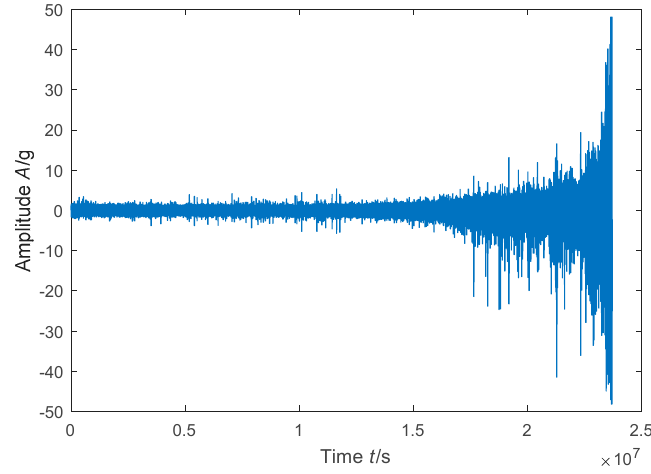
Figure 9. Whole life-cycle time domain waveform of bearing 1_3.